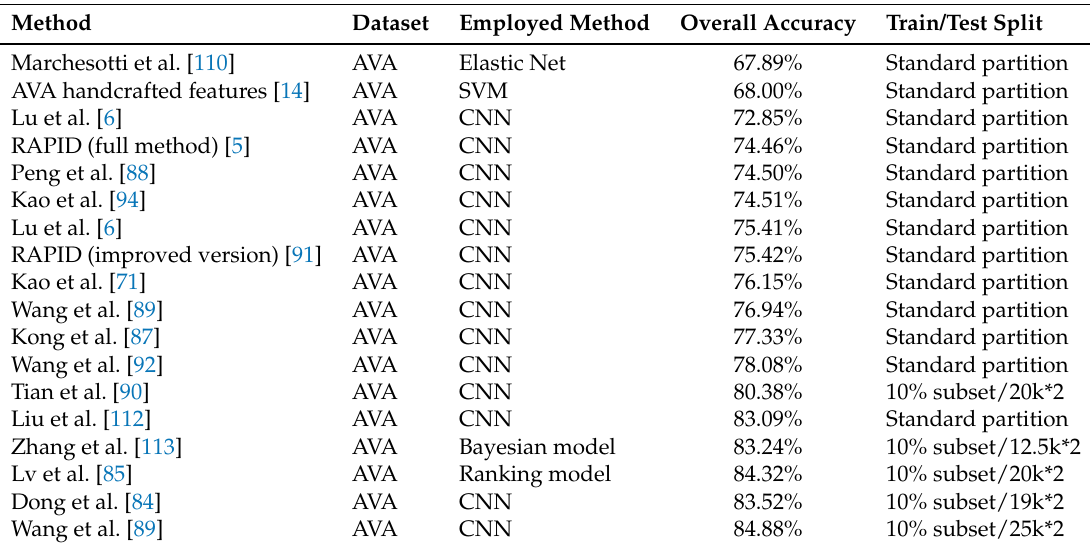
Table 1. The subset of the reviewed methods that use AVA as the training dataset. We can notice the sensible improvement carried by the latest deep learning techniques, in terms of overall accuracy. Further, it seems that a proper balancing of the training and test set provides classifiers that obtain better performances. RAPID, RAting PIctorical aesthetics using Deep